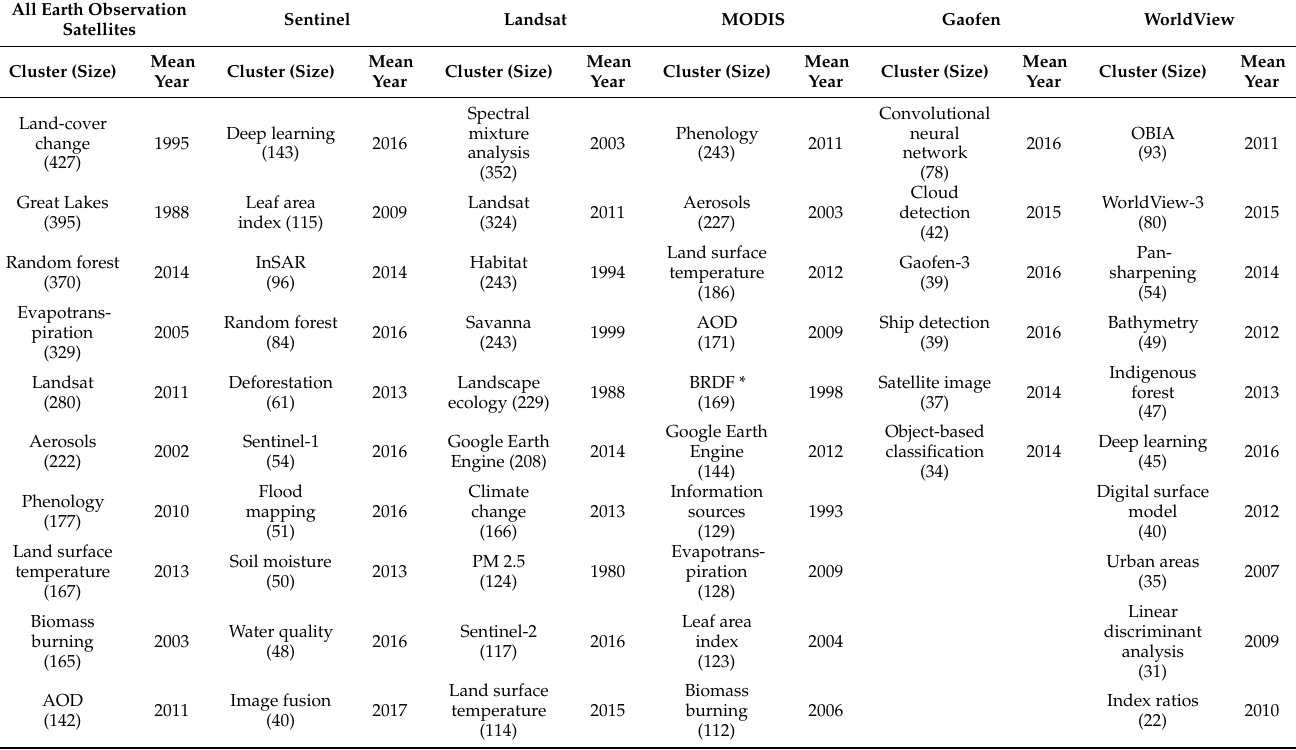
Table 2. Top 10 clusters in the Earth observation satellite co-citation